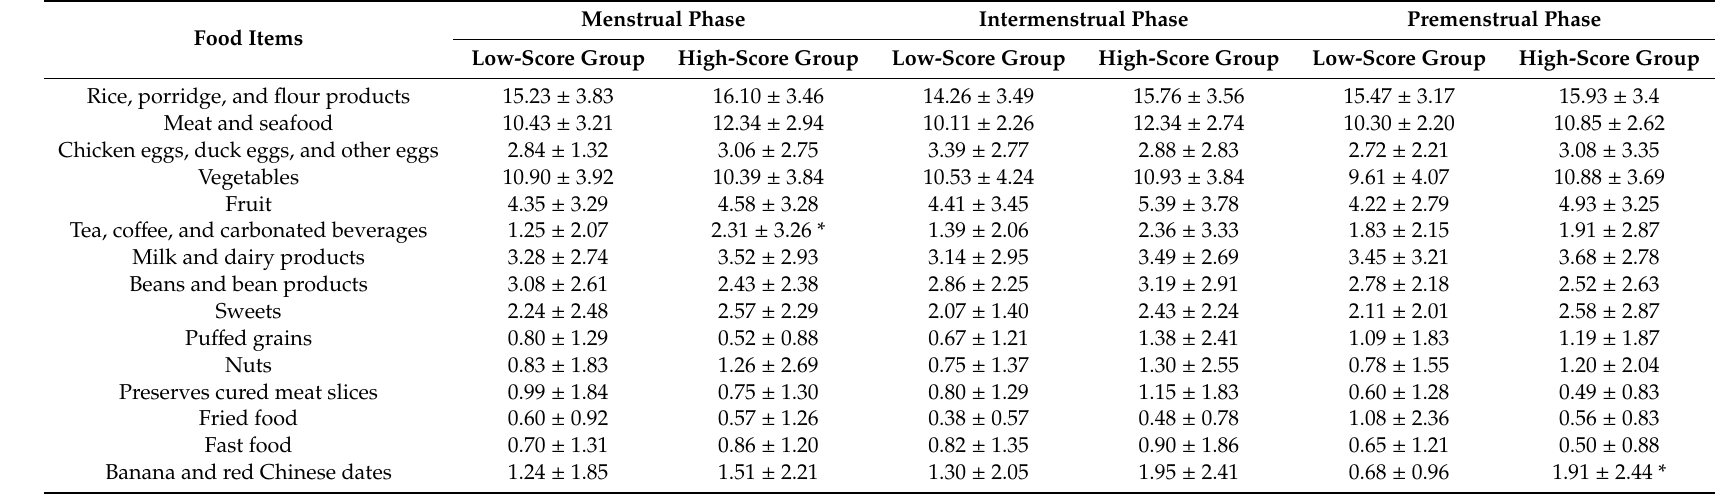
Table 2. Dietary intake frequencies of the low-score and high-score groups during each menstrual phase (mean ± standard